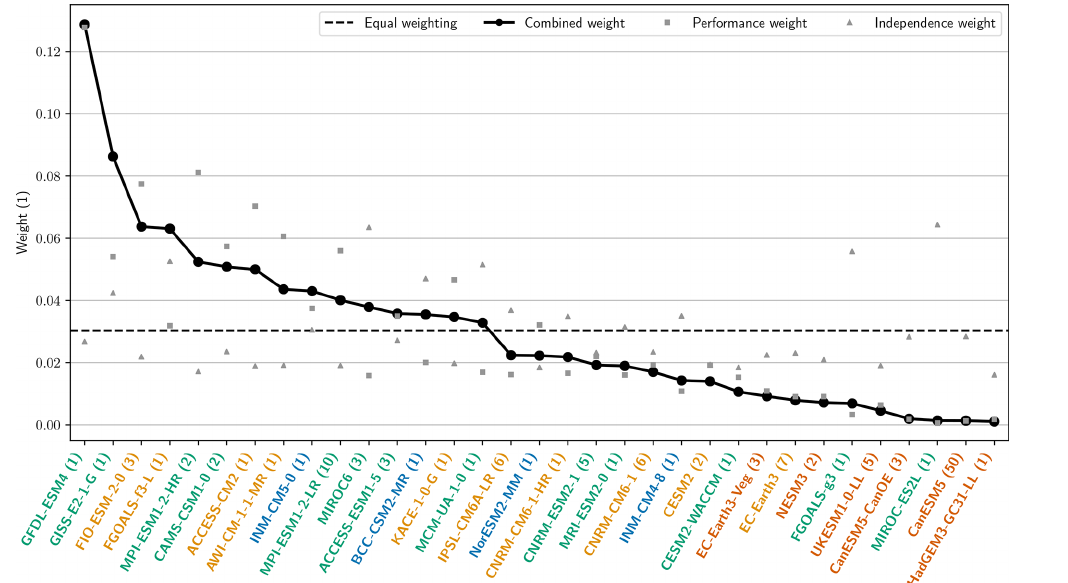
Figure 4. Combined independence–performance weights for each CMIP6 model (line with dots) as well as pure performance weights (squares) and pure independence weights (triangles). All three cases are individually normalized, and the equal weighting each model would receive in a normal arithmetic mean is shown for reference (dashed line). The labels are colored by each model’s TCR value: > 2 . 5 ◦ C – red, > 2 ◦ C – yellow, > 1 . 5 ◦ C – green, and ≤ 1 . 5 ◦ C – blue. The number of ensemble members per model is shown in parentheses after the model